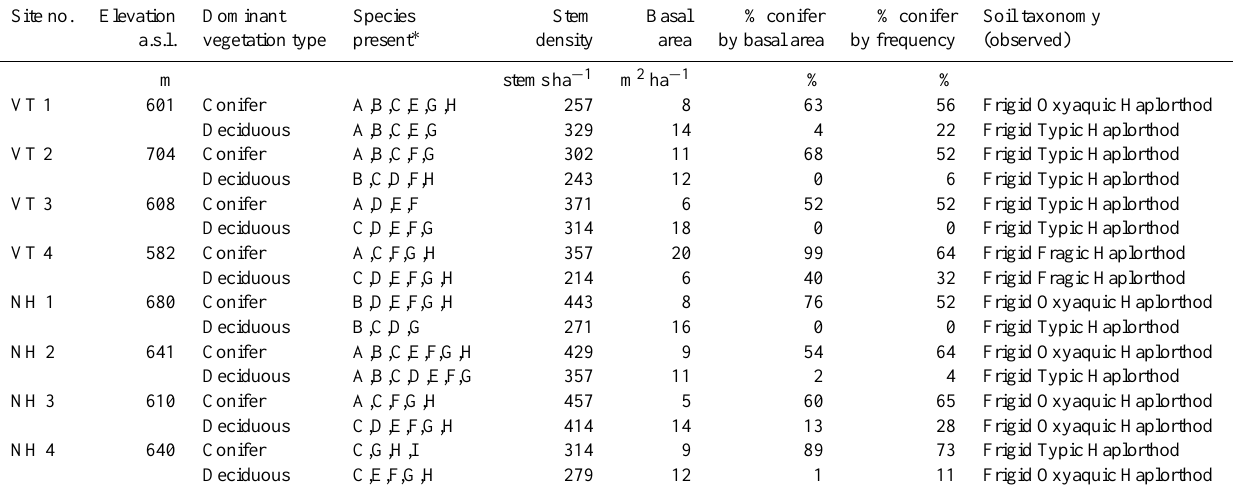
Table 1. Forest stand